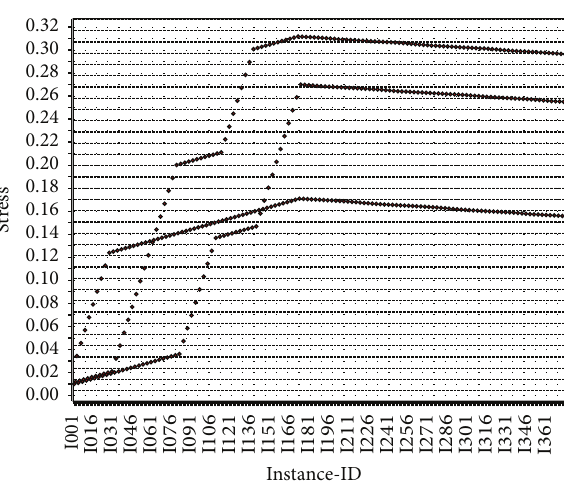
Figure 5: Stress-level analysis in the elderly with respect to the number of